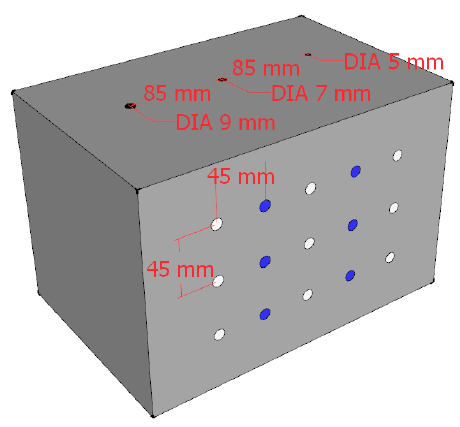
Figure 7. Block I detection position.